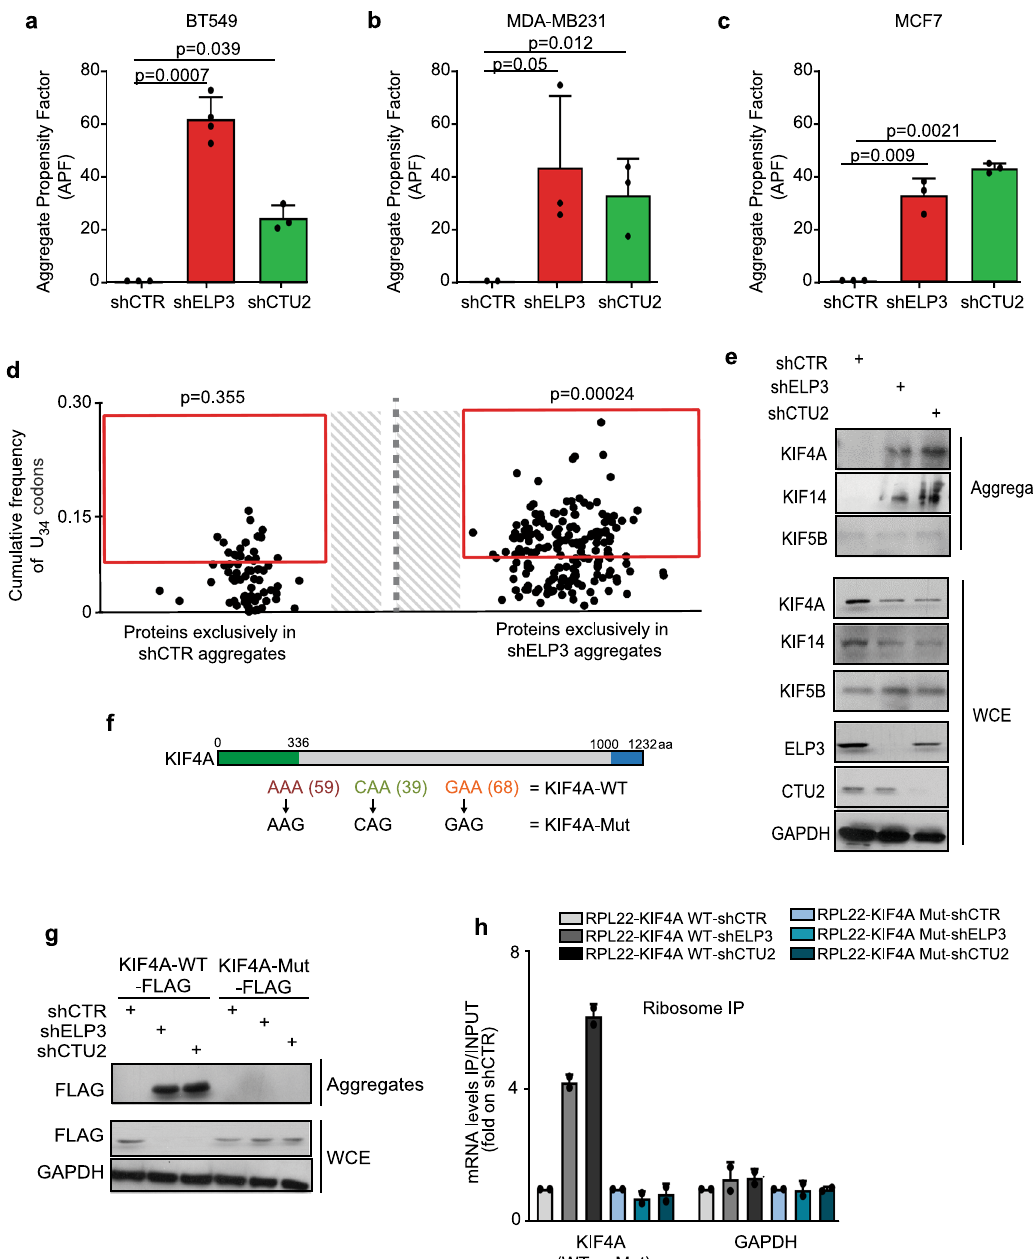
Fig. 3 Loss of U 34 -enzymes leads to protein aggregation in a codon-dependent manner. a – c Protein aggregation was measured by FACS in BT549 ( a ), MDA-MD231 ( b ), and MCF7 ( c ) upon loss of ELP3 or CTU2 ( n = 3 independent experiments, two-tail t -test, data are mean + s.d). d Protein content of aggregates of MCF7 cells depleted or not of ELP3 were assessed by proteomics ( n = 1 independent experiment); proteins exclusively found in shELP3 or shCTR conditions are shown. Enrichment of U 34 -codons was assessed by χ 2 test (two-sided). e Levels of indicated proteins were determined by western blot in whole-cell extracts (WCE; loaded 30 μ g) and aggregates (isolated from >1 mg of protein extract) of MCF7 cells depleted of ELP3 or CTU2 ( n = 2 replicates). f Schematic representation of KIF4A mutant. The kinesin domain (green) and the globular region (blue) of the protein are indicated. g Protein levels of whole-cell extracts (WCE) and aggregates of MCF7 cells stably overexpressing FLAG-RPL22 and the identi fi ed KIF4A mutants in the presence or absence of ELP3 or CTU2 ( n = 3 replicates). h qRT-PCR after ribosome immunoprecipitation of indicated cells. n = 2 independent experiments, data are mean +